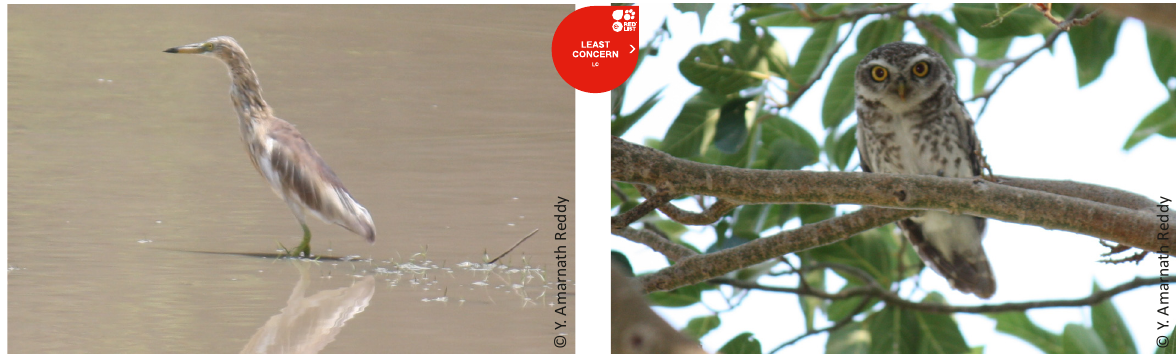
Image 4. Athene brama Spotted Owlet